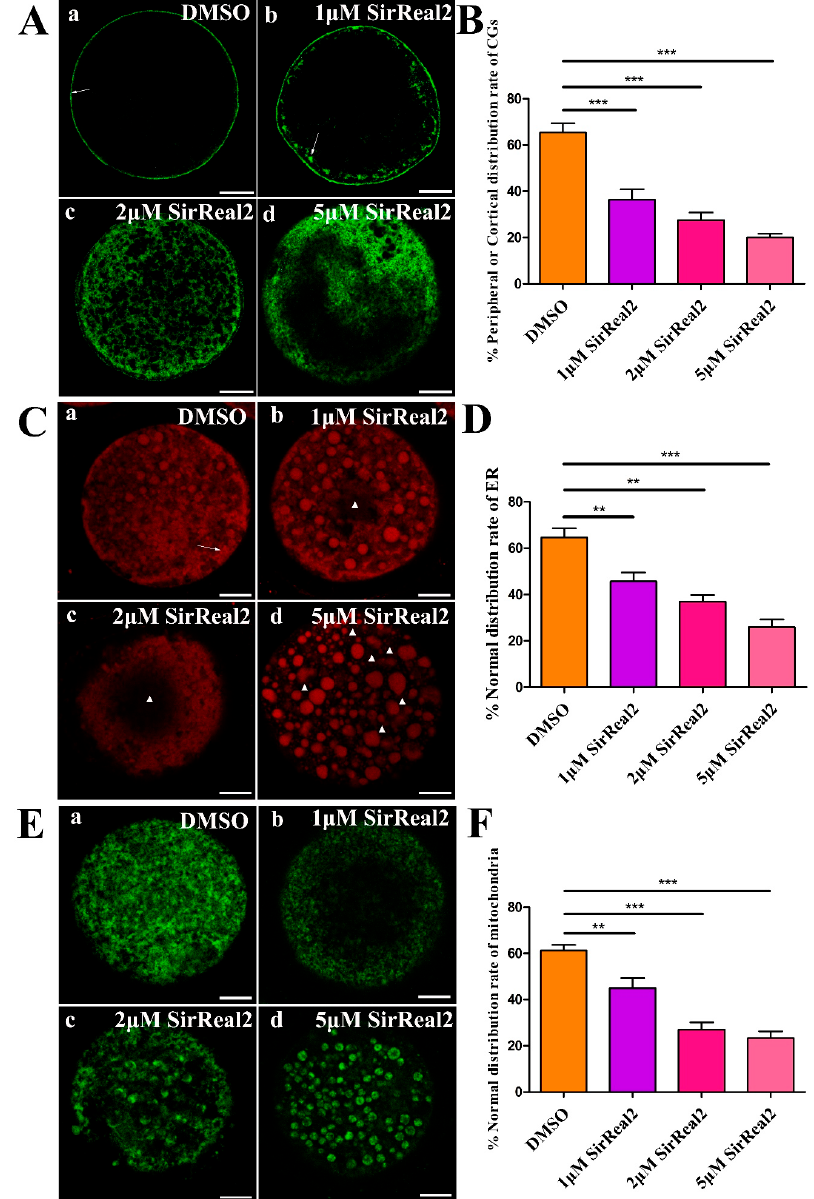
Figure 4. SIRT2 disturbs the redistribution of organelles. ( A ) Representative images of CG distribution patterns visualized with fluorescein isothiocyanate conjugate lectin from peanut (FITC – PNA) in the control group (a) and SirReal2-exposed groups (b – d). (a) Peripheral CG distribution (arrowheads). (b) Cortical distribution (arrowheads). (c) Homogeneous distribution. (d) Nonhomogeneous or abnormal